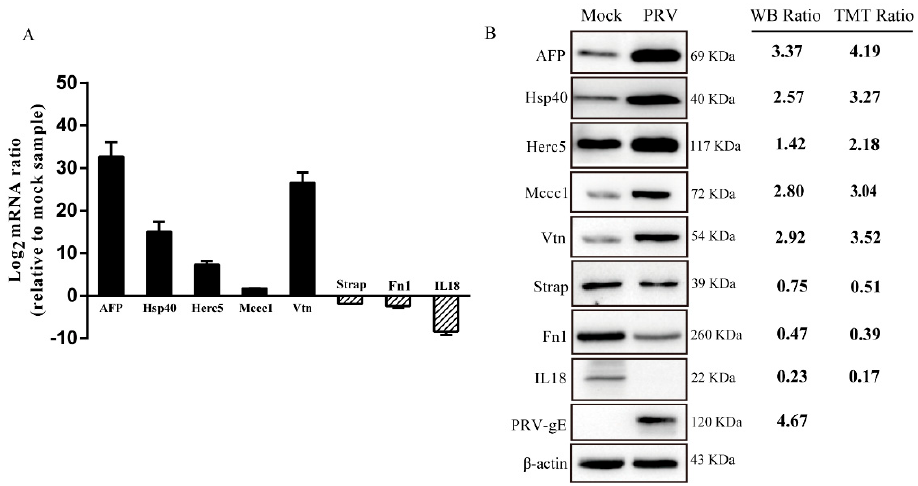
Figure 3. Validation of the randomly selected DEPs between mock- and PRV-infected ISG15 − / − -PK15 cells. ( A ) Quantitative real-time PCR (RT-qPCR) analysis was performed to determine the relative mRNA expression levels of the randomly selected DEPs. ( B ) Western blot (WB) analysis of the expression of the selected proteins. The WB ratio and TMT ratio (infection/mock) are shown on the right side. The β -Actin was used as the housekeeping gene.